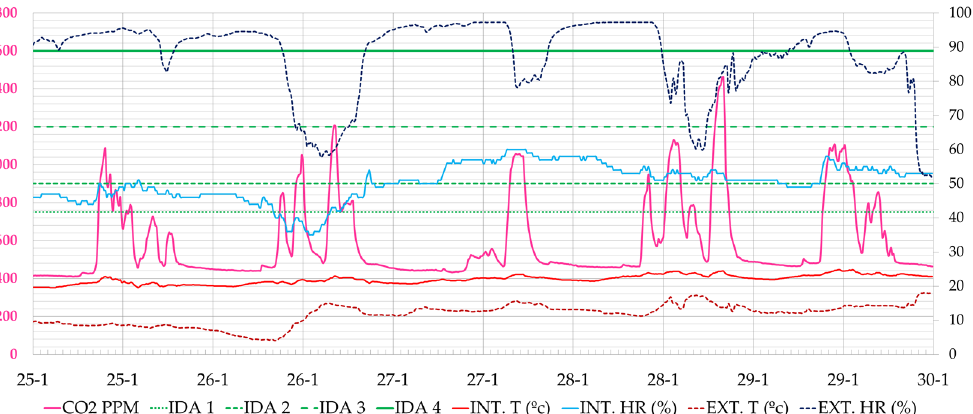
Figure 17. Evolution of CO 2 concentration, interior and exterior temperature and relative humidity in classroom A 2.1 during the week of 2021-01-25 to 2021-01-31 (Phase II). Source: authors. are within the comfort limits of the different standards analysed (Figure 18).